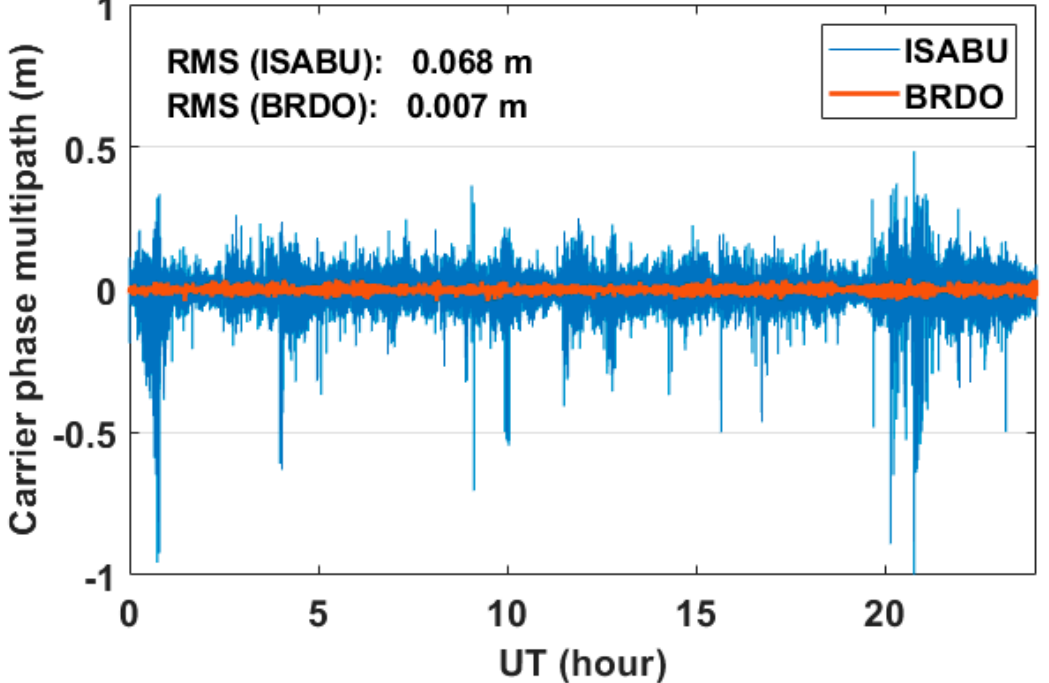
Figure 6. Time series of GPS L3 carrier phase multipath errors on DOY 242, 2018. The solid blue line and solid brown line represent carrier phase multipath errors at the vessel ISABU and at the ground BRDO station, respectively.